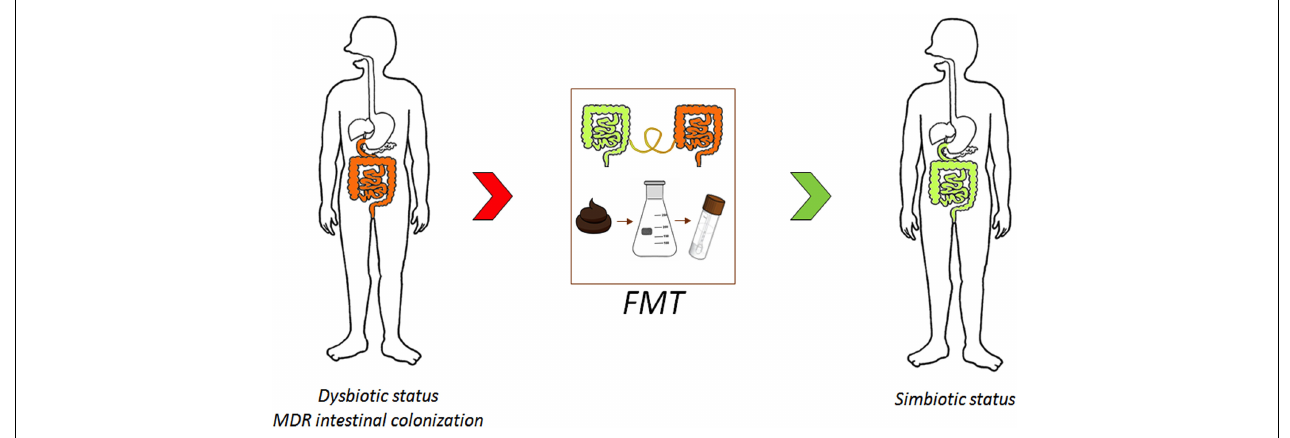
FIGURE 3 | Combating antimicrobial resistance (AMR) through microbiota